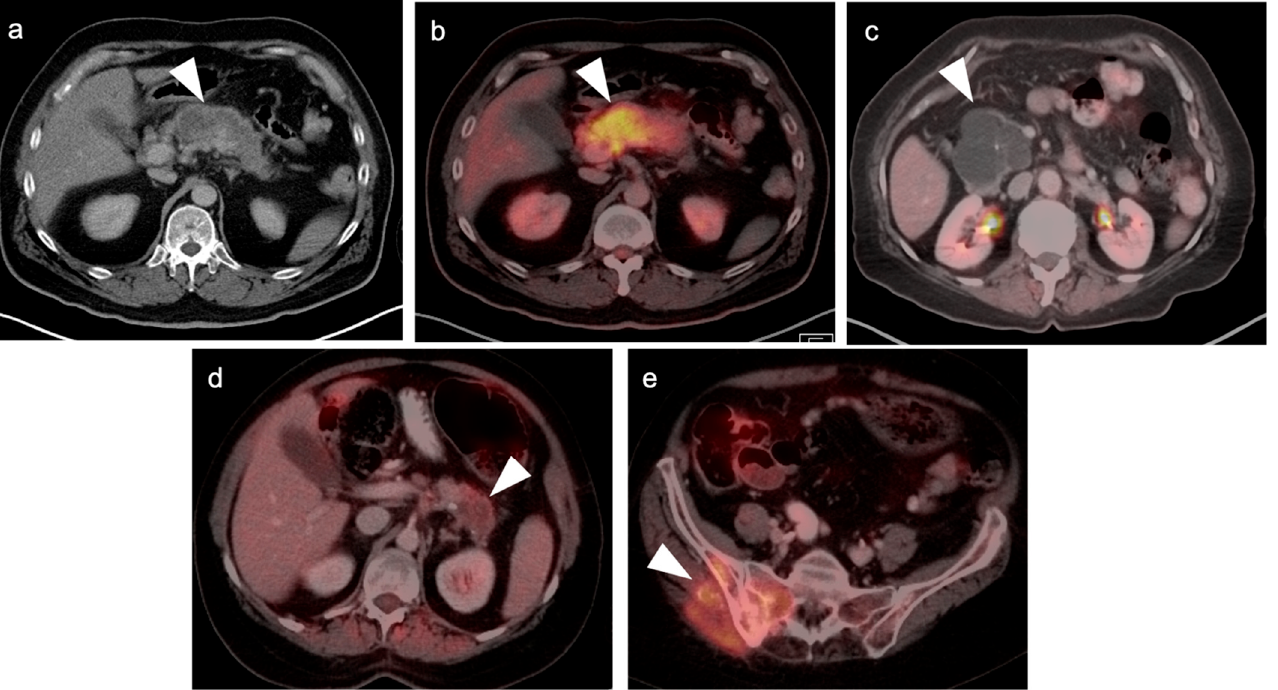
Figure 27. Highly variable appearance of highly mucinous pancreatic neoplasms on FDG PET-CT: ( a – e ). ( a , b ) Mucinous adenocarcinoma of the body of the pancreas is low attenuation on axial contrast-enhanced CT ( a ) and yet highly metabolically active on axial fused FDG PET-CT ( b ) (white arrowheads); ( c ) Complex cystic mass in the head of the pancreas is a highly mucinous cystadeno- carcinoma and shows no metabolic activity on axial fused FDG PET-CT (white arrowhead). The differential diagnosis would include pseudocyst from prior pancreatitis; ( d ) A mucinous adenocar- cinoma of the tail of the pancreas shows only mild uptake on axial fused FDG PET-CT (white ar- rowhead); ( e ) The same pancreatic mass as ( d ) has metastasized to the right iliac bone and sacrum (white arrowhead). Although the pancreatic mass shows only mild metabolic activity, the pelvic metastasis from this same tumor is strongly hypermetabolic.